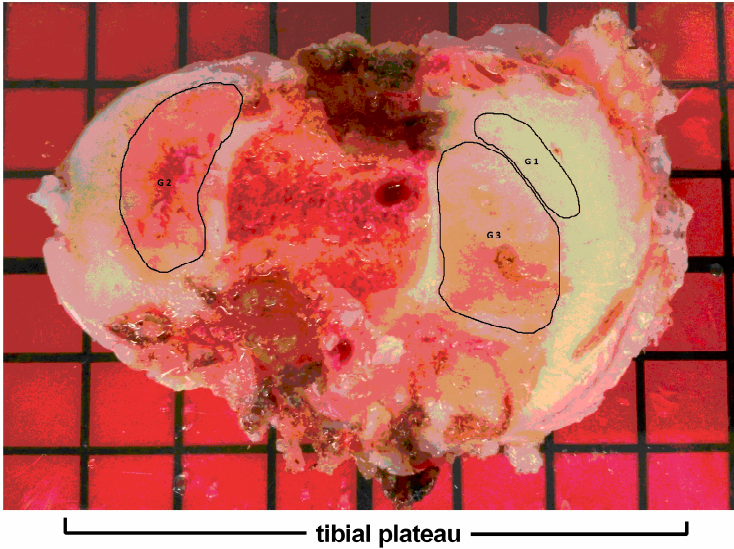
Figure 7. Representative OA tibial plateau obtained after a total knee joint replacement surgery. The Outerbridge’s classification was used to determine the grade of the interesting area indicated by black line (Grade 1/G1: minimal cartilage degradation; Grade 2/G2: partial-thickness defect with fissures on the surface; Grade 3/G3: fissures to the level of subchondral bone.